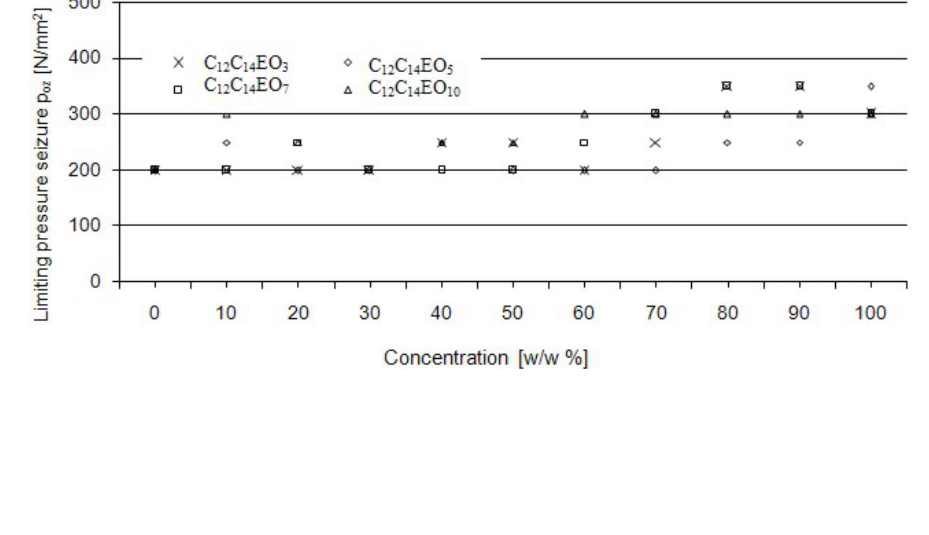
Figure 9. The effect of concentration on the value of limiting pressure of seizure (p aqueous solutions of alcohols ethoxylated with 3–C